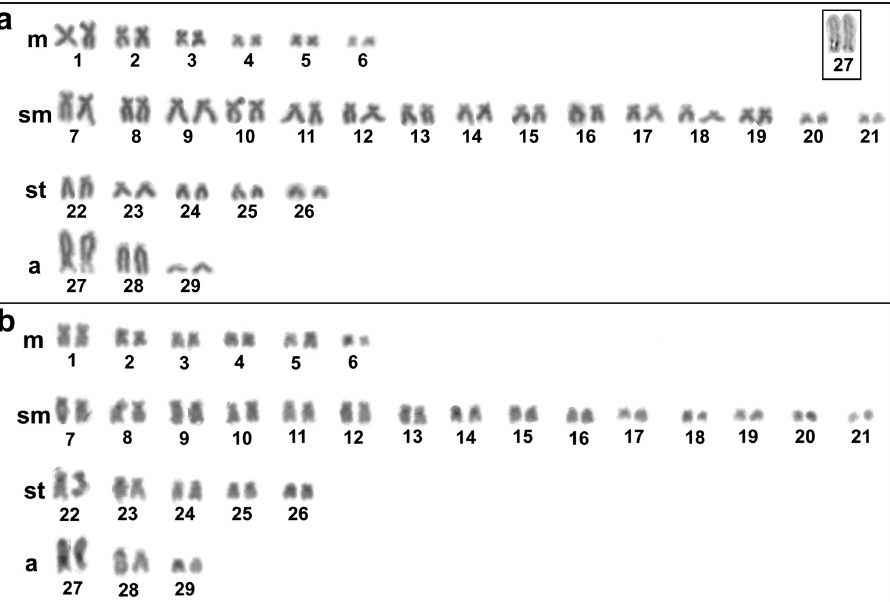
Figure 3. Metaphases of Pterygoplichthys anisitsi stained with ( a ) Chromomycin A indicate pair 10 and arrows head indicate pair 9 (NOR-bearing).